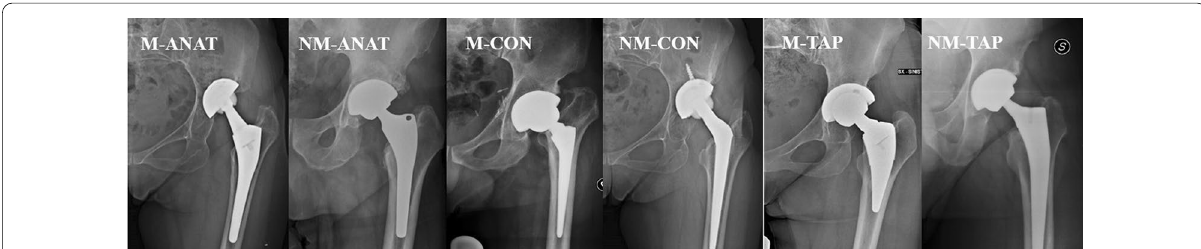
Fig. 1 A representative stem model was provided for every cohort. M-ANAT: Ancafit, Cremascoli Ortho; NM-ANAT: AptaFix, Adler Ortho; M-CON: Acuta, Adler Ortho; NM-CON: Wagner Cone, Zimmer; M-TAP: SMF, Smith & Nephew; NM-TAP: Corae, Adler Ortho